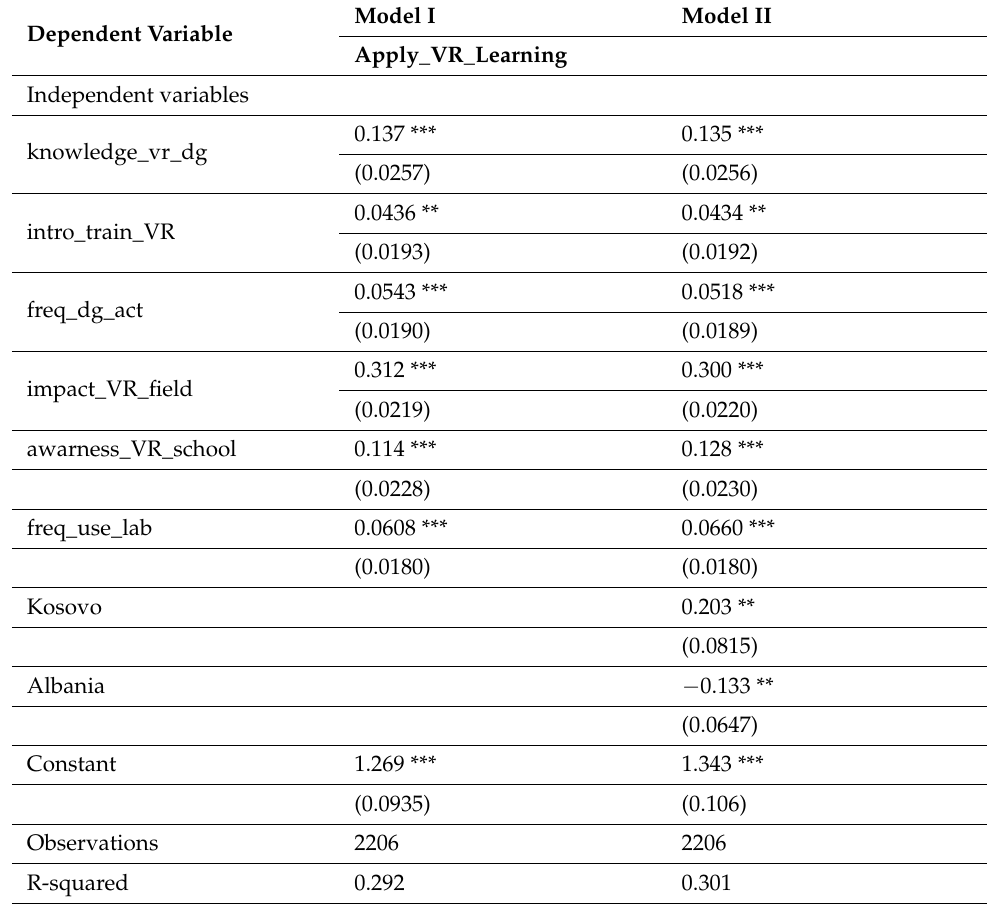
Table 4. Statistical analysis of students. Robust standard errors in parentheses. *** p < 0.01 ** p <